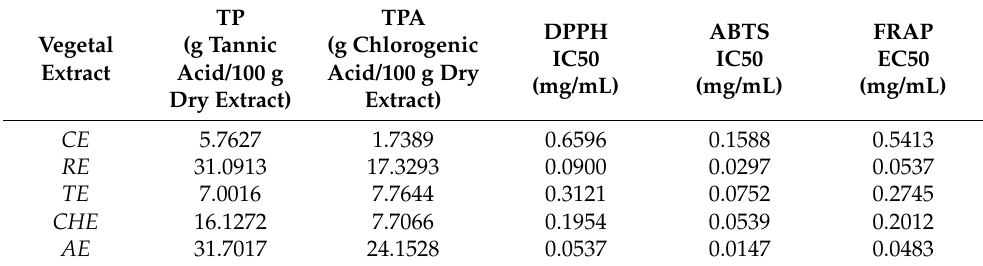
Table 8. Concentrations of relevant active principles and antioxidant values.